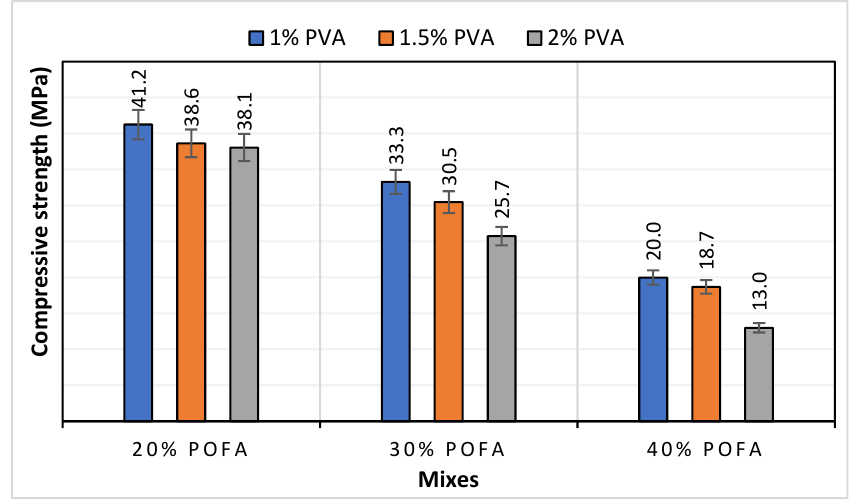
Figure 5. Compressive strength of POFA-ECC.